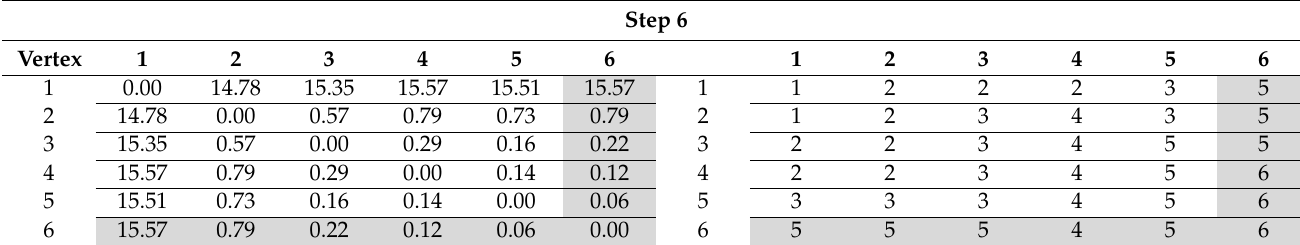
Table A6. The step 6 graphical process of Floyd–Warshall algorithm.